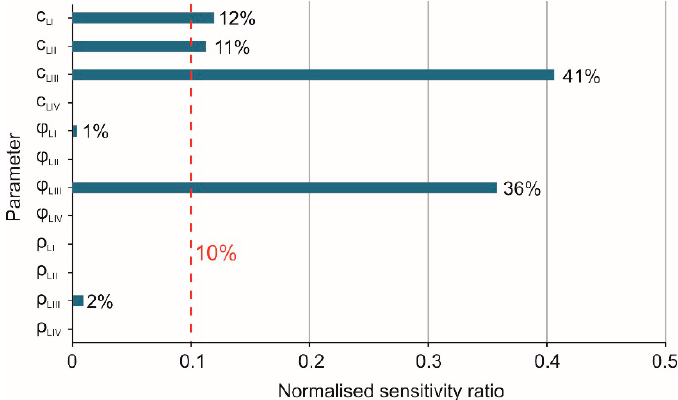
Figure 10. Sensitivity diagram of parameters adopted for the numerical stability analysis of the 18S landslide in the Be ł chatów open-pit mine.